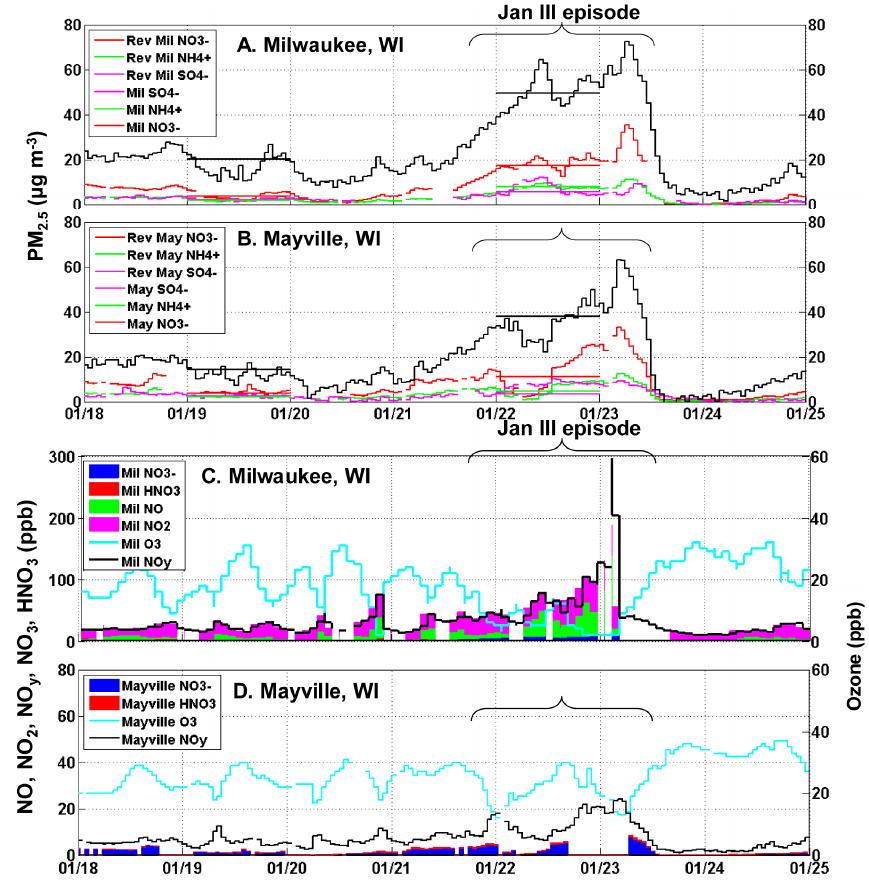
Fig. 8. Seven day time series from the Wisconsin sites that includes the strongest air pollution episode (Jan III episode beginning during the afternoon of 21 January and ending midday on 23 January). Total and inorganic aerosol species (panels A and B ) show the agreement between the continuous and integrated (flat lines 1 day in 3) samplers, and the large contribution of nitrate to the episode, particularly at the Mayville site. Black lines are for total PM 2 . 5 . Gas species and NO y breakdown (panels C and D ) show several important system features (discussed in the text). Note the left hand axis scale change between Milwaukee (panel C ) and Mayville (panel D ).